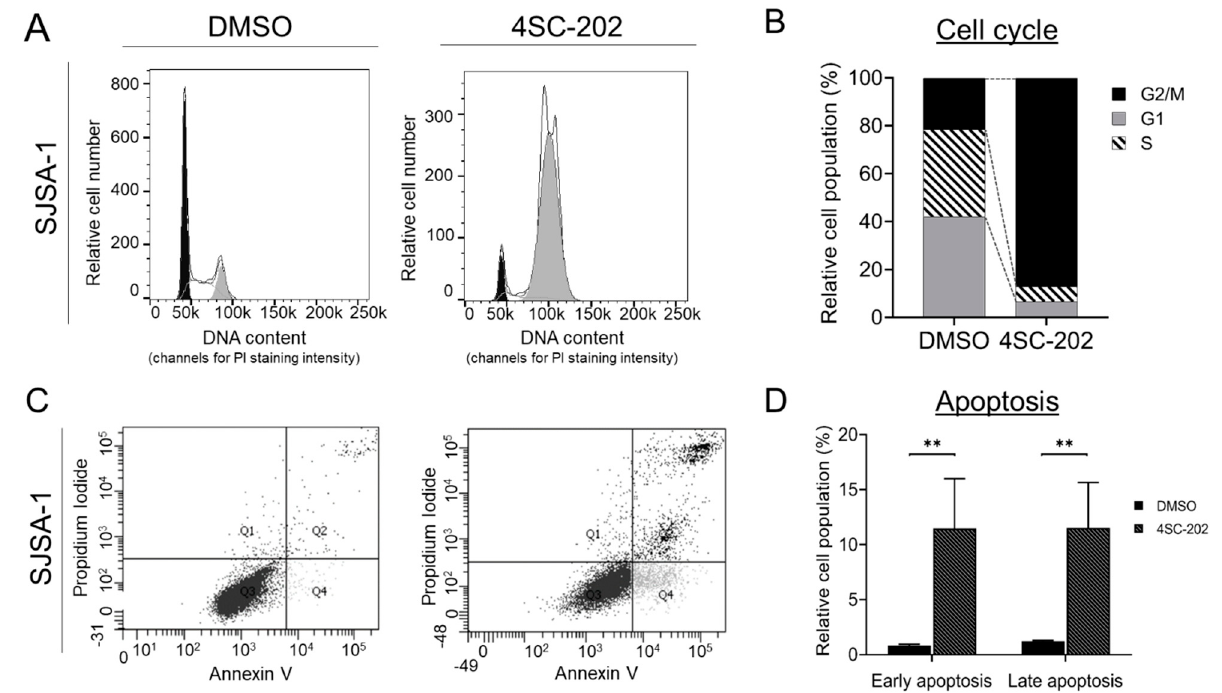
Figure 5. Effect of 4SC-202 on the cell-cycle distribution and apoptosis in human SJSA-1 OS cells. ( A ) Representative cell-cycle flow cytometry profiles of cells treated with or without 4SC-202 for 24 h. The DNA content of cells was analyzed by flow cytometry after staining with propidium iodide. ( B ) Relative cell population quantified data from cell-cycle profiles in A. ( C ) Representative flow cytometry scatter plots of cells treated with or without 4SC-202 for 24 h and stained with annexin V (positive for apoptotic cells) and propidium iodide. ( D ) Quantification of apoptotic profiles for relative cell population from C. ** p < 0.01. Data are presented as mean (SD).